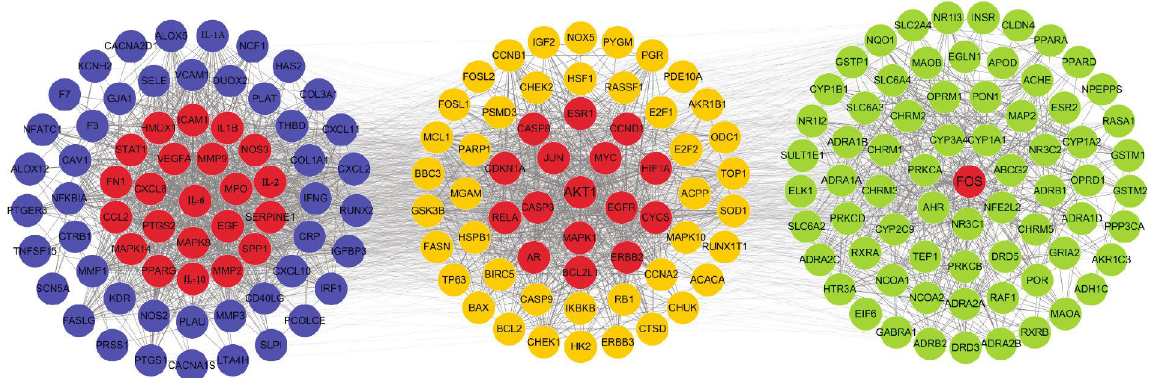
Figure 6: PPI network of target genes based in di ff erent cluster. Clusters 1, 2, and 3 are represented by dark blue, orange, and green, respectively. Red nodes represent the key targets. And the lines among nodes display the relationship between di ff erent target